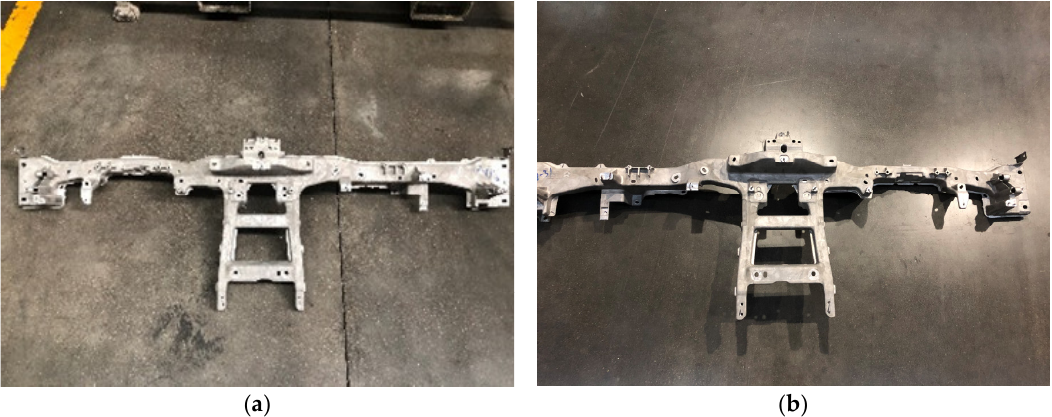
Figure 10. CCB D ie-casting: ( a ) before optimization ; ( b ) after optimization .